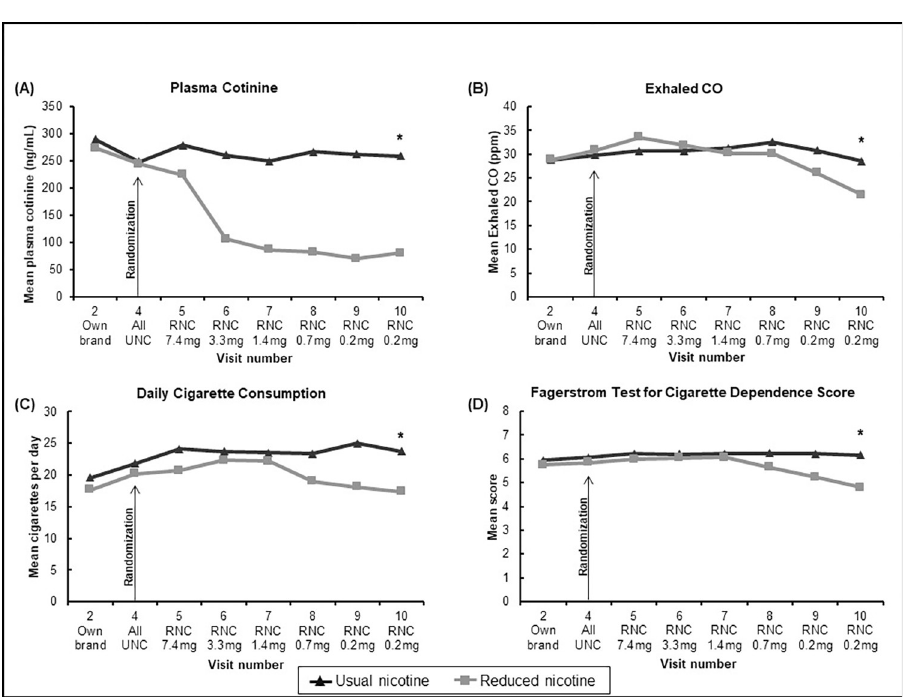
Fig 2. 2A-2D. Changes in plasma cotinine, exhaled CO, daily cigarette consumption, and FTND nicotine dependence score among completers (n = 143) smoking either Usual Nicotine Content (n = 74) cigarettes or Reduced Nicotine Content (n = 69) cigarettes. � indicates statistically significant between group difference at Visit 10, controlling for Visit 4 baseline.